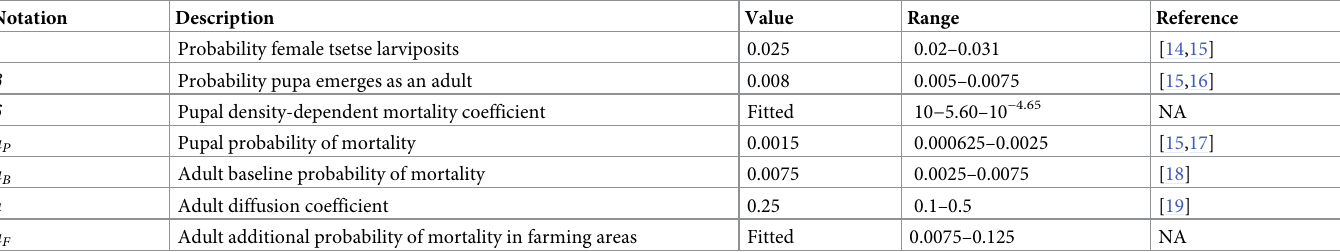
Table 1. Parameters and values used in the model of tsetse population dynamics. Values are per 0.25 days. Each cell in the area modelled is a square of side 500